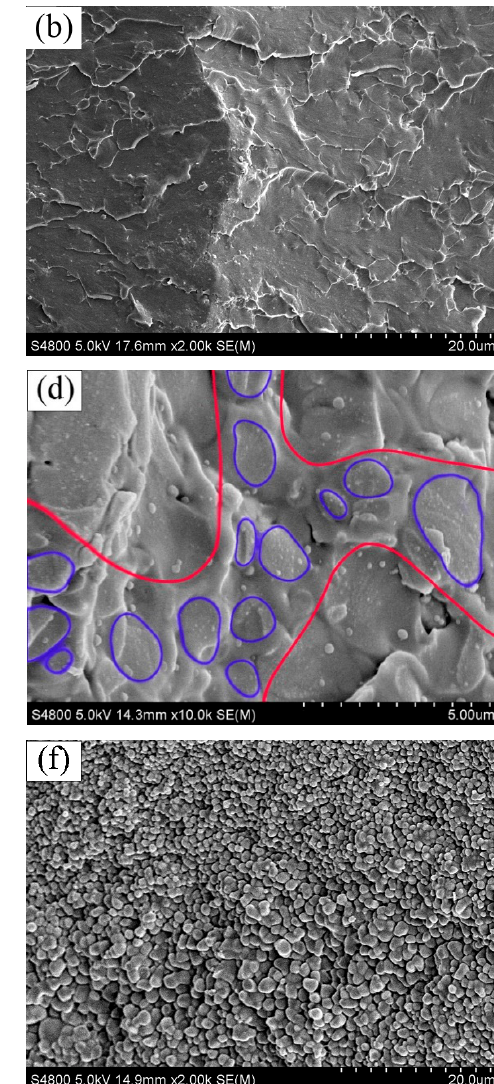
Figure 2. Morphologies of the impact fracture surfaces of bicomponent epoxy resin binary (BE) blends with polyaryletherketone (PAEK) powders: ( a ) pristine BE; ( b ) PAEK-10/BE; ( c,d ) PAEK-20/BE; ( e ) PAEK-30/BE; ( f ) PAEK-40/BE.